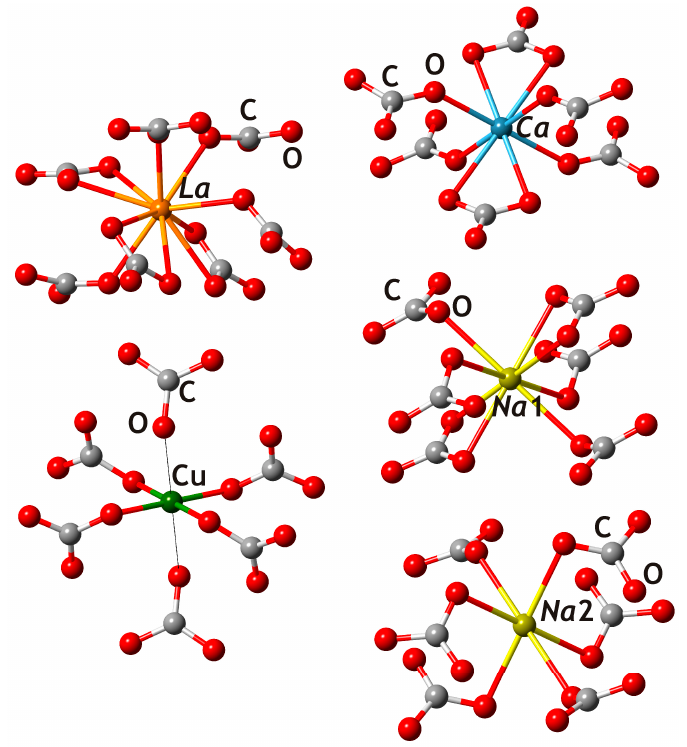
Figure 2. Coordination environments of the La, Ca, Cu, Na1, and Na2 sites in the crystal structure of paratooite-(La). Legend: La, Ca, Na, C, and O atoms are shown as orange, blue, greenish-yellow, gray, and red spheres, respectively.